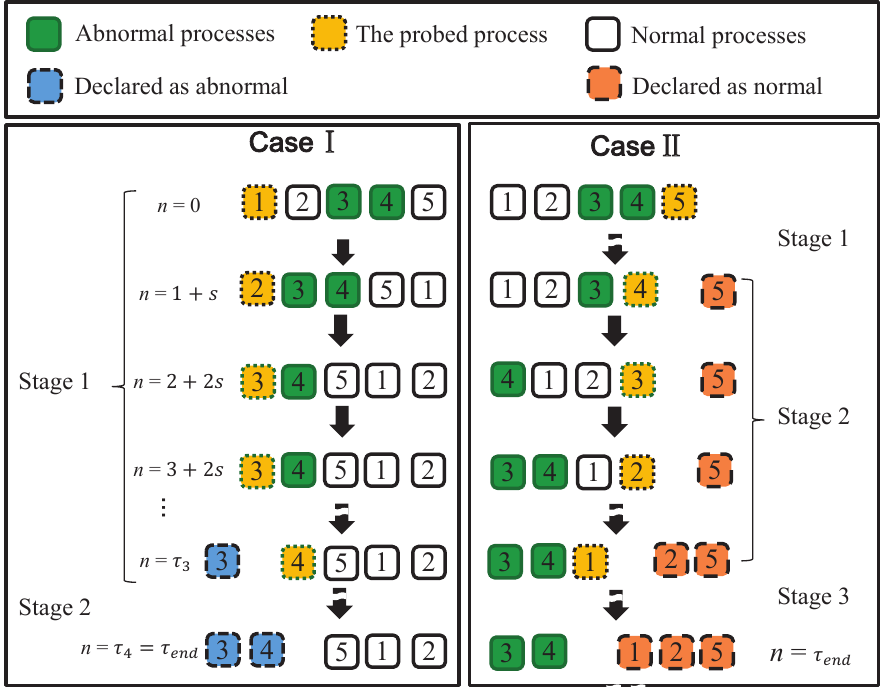
Figure 1. Illustration of the DMSC policy ( M = 5 and L =